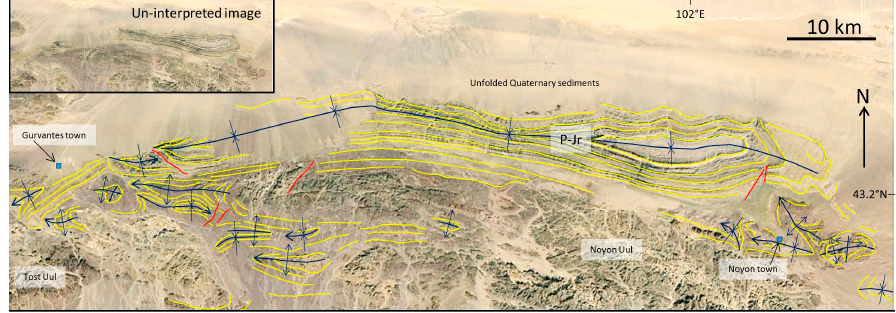
Figure 2. Google Earth (© 2016 DigitalGlobe) image interpretation showing bedding traces (yellow lines) and major fold hinges (dark blue lines) in Permian-Jurassic (P-Jr) rocks in northern Noyon Uul region, southern Mongolia. Red lines are faults. Inset shows un-interpreted scene. See Figure 1 for location.